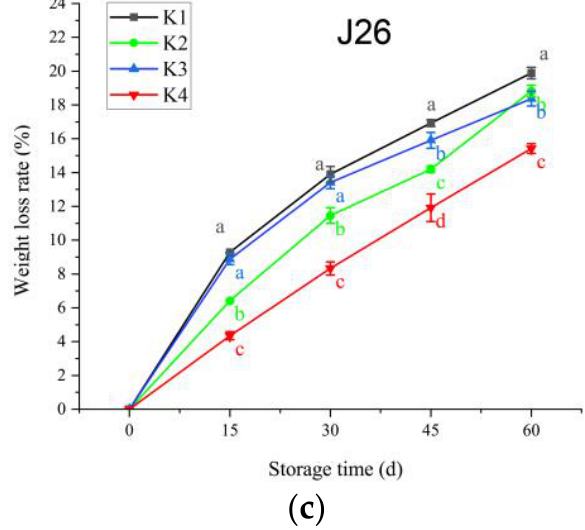
Figure 4. Weight loss rate of the tuberous root of different UCZ treatments during storage. ( a ) Z13; ( b ) Z33; ( c ) J26. Values within the same storage day of the same year followed by the same letter are not significantly different at the 5% level according to ANOVA-Duncan’s multiple range test. K1: Normal basal fertilizing without UCZ; K2: Normal basal fertilizing with UCZ; K3: Rich basal fertilizing without UCZ; K4: Rich basal fertilizing with UCZ.